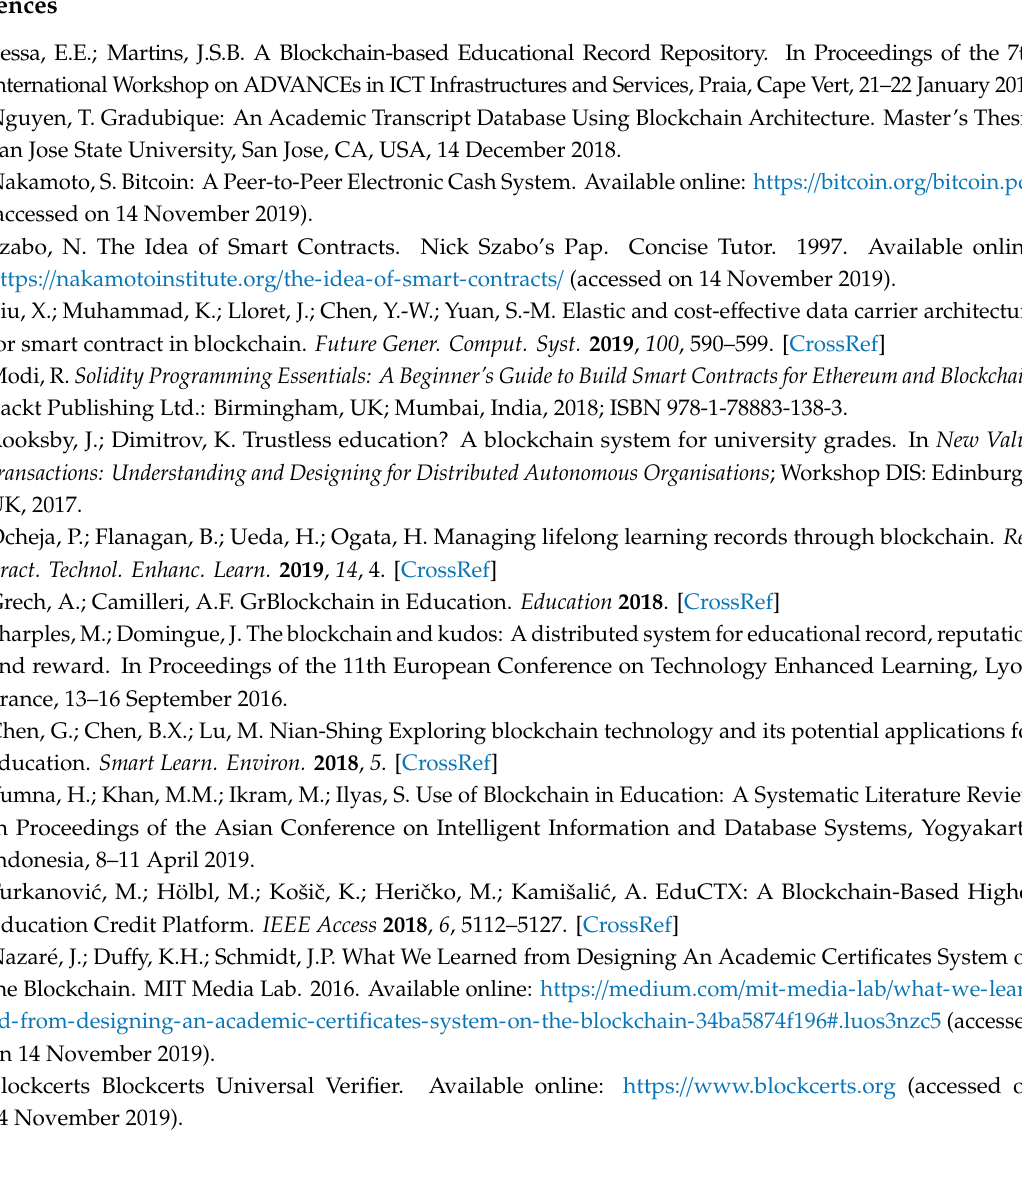
Figure A3. The ERD of examination scheduling [33]